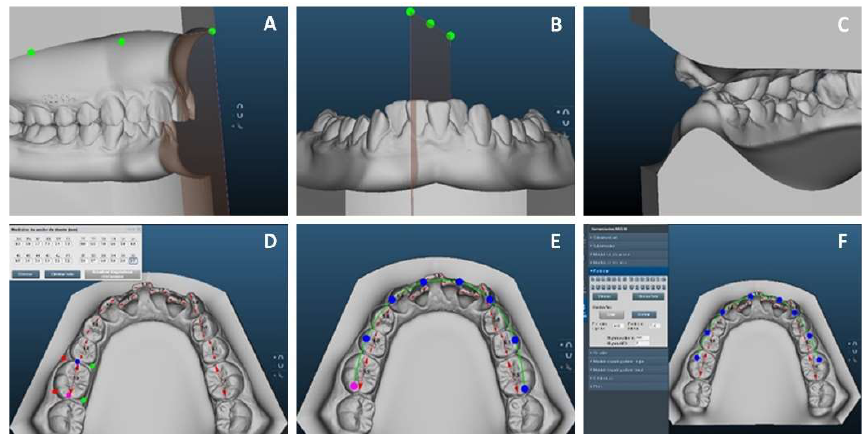
Figure 1. ( A , B ) Digital overjet and overbite measurement. ( C ) Posterior view of buccal posterior crossbite for digital measurement. ( D ) Tooth width measurement in Digicast ® . ( E ) Preparation of the ideal arch to determine the required space. ( F ) Digicast ® section to digitally measure crowding.